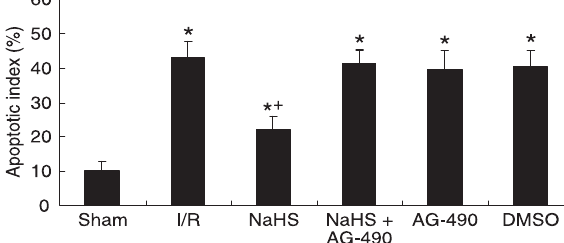
Figure 3. Percentage of TUNEL-positive cells in various groups. Six hearts were used in each group. Data are reported as means ± SD. *P < 0.05 vs Sham; + P < 0.05 vs I/R (one-way ANOVA). For abbreviations of groups, see legend to Figure 1.